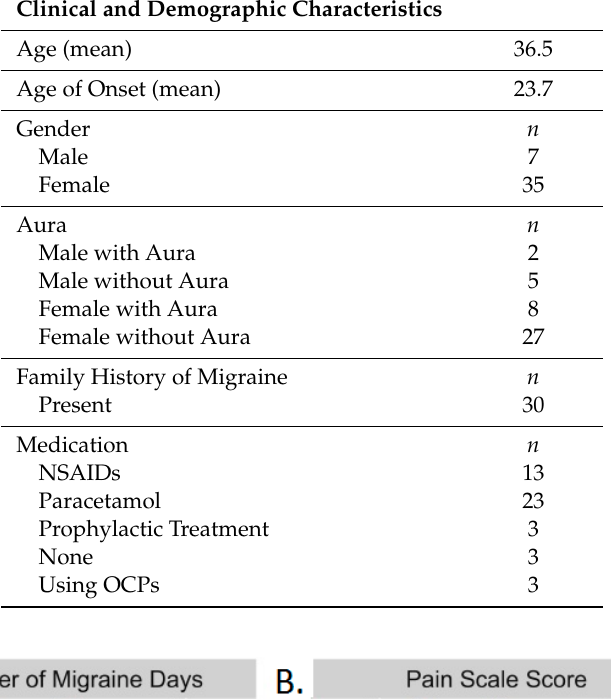
Table 1. Clinical and demographic characteristics of the participants. N: number of patients; NSAID: Non-steroidal anti-inflammatory drugs; OCP: Oral contraceptive pills.